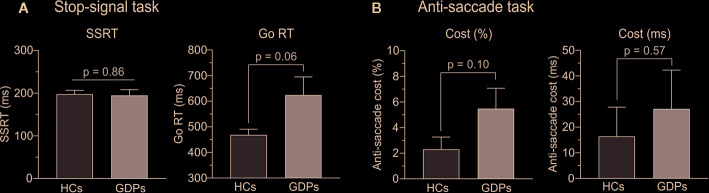
Behavioral measures of motor inhibition. (A) Stop-signal reaction time (SSRT) and reaction time (RT) on go trials during the stop-signal task in HCs (light gray) and GDPs (dark gray). (B) Anti-saccade cost, defined as the difference between the scores (% of errors and RTs) in incongruent and control trials, in HCs and GDPs (same color code).